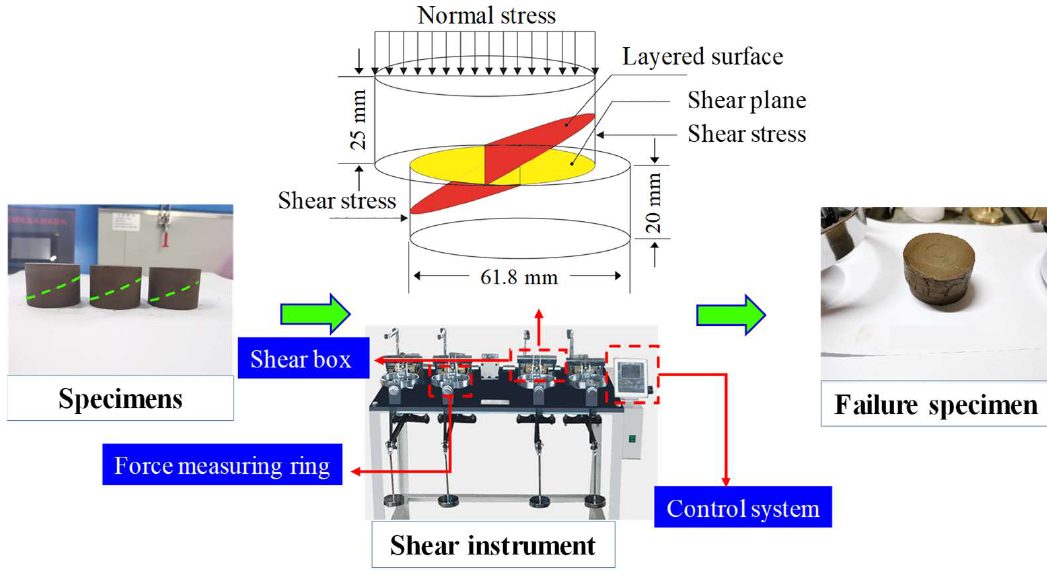
Figure 3. Direct shear apparatus in this study.